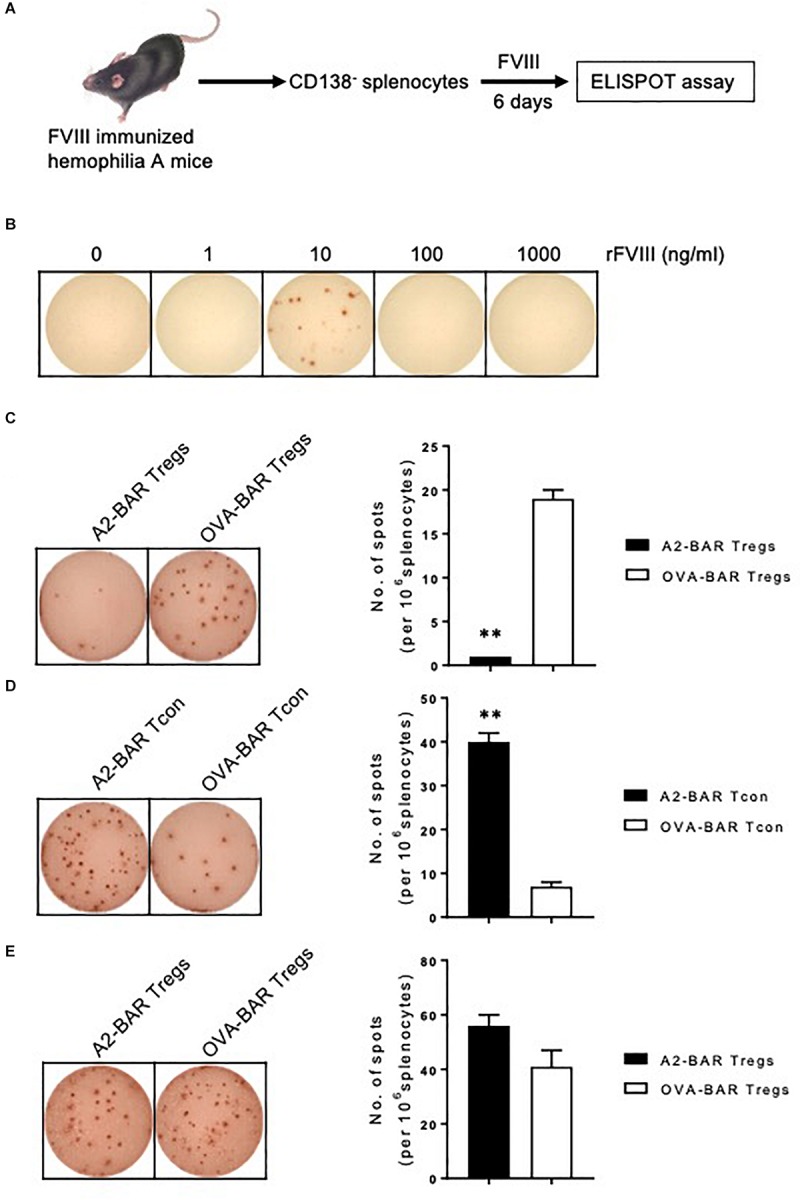
FVIII A2-BAR mouse natural Tregs suppressed FVIII-specific memory B cells in vitro. (A) Schematic illustration for the detection of FVIII-specific memory B cells. Splenocytes from FVIII-immunized E16 mice were depleted for plasmablasts/plasma cells with CD138 microbeads by MACS. The CD138– splenocytes were cultured in complete culture medium in the presence of optimal amount of rFVIII for 6 days. At the end of the culture, the anti-FVIII antibody secreting cells (ASC), which reflect the number and activity of FVIII-specific memory B cells, were enumerated with a FVIII-specific B-cell ELISPOT assay. (B) The effect of rFVIII concentration on the detection of FVIII-specific memory B cells. CD138– splenocytes were cultured in complete culture medium in the presence of increasing amounts of rFVIII for 6 days. The anti-FVIII ASC spots were detected by a FVIII-specific B-cell ELISPOT assay. (C) A2-BAR mouse natural Tregs significantly suppressed FVIII-specific memory B cells in vitro. In 48-well culture plates, CD138– splenocytes (6 × 106) were co-cultured with 150-fold less (40,000) A2-BAR or OVA-BAR mouse natural Tregs, in the presence of 10 ng/ml rFVIII for 6 days. The anti-FVIII ASC spots were detected by FVIII-specific B-cell ELISPOT assay, and visualized with AEC substrate (BD Bioscience). The ELISPOT plates were analyzed using ImmunoSpot analyzers (CTL Immunospot). (D) Expressing A2-BAR on Tcon did not confer suppressive function on FVIII-specific memory B cells. The experiment was performed as described in Figure 3C, except that BAR Tcon cells were used instead of Tregs. (E) The suppression of A2-BAR mouse natural Tregs on FVIII-specific memory B cells was contact-dependent. The suppression assay was set up as described in Figure 3C, except a Transwell plate was used. The Tregs were placed in the lower chamber, and the CD138– splenocytes were placed in the upper chamber. No statistical difference was found between the A2-BAR Tregs group and the control OVA-BAR Tregs group. The histograms summarize the data on the left, and the data are expressed as mean ± SEM (C–E). **p < 0.01 between the A2-BAR group and the control OVA-BAR group by the Student’s t-test (C,D).